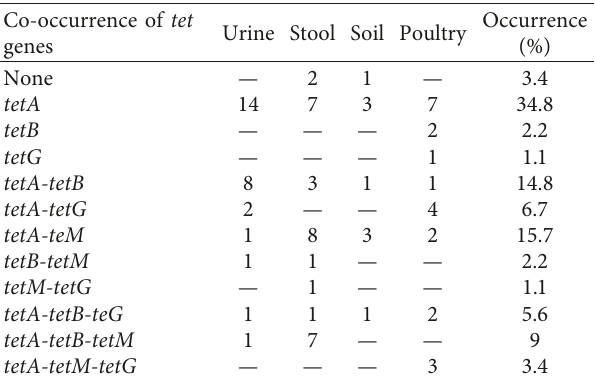
Figure 3: Distribution of mono-occurrence and co-occurrence of tet genes in E. coli . Table 3: Co-occurrence of tetracycline-resistant genes in E. coli ( n �